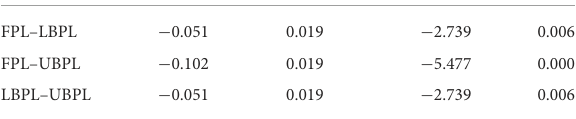
TABLE 7 Correlation results of the determinants of FPL, LBPL and UBPL ( n = 196). Variable